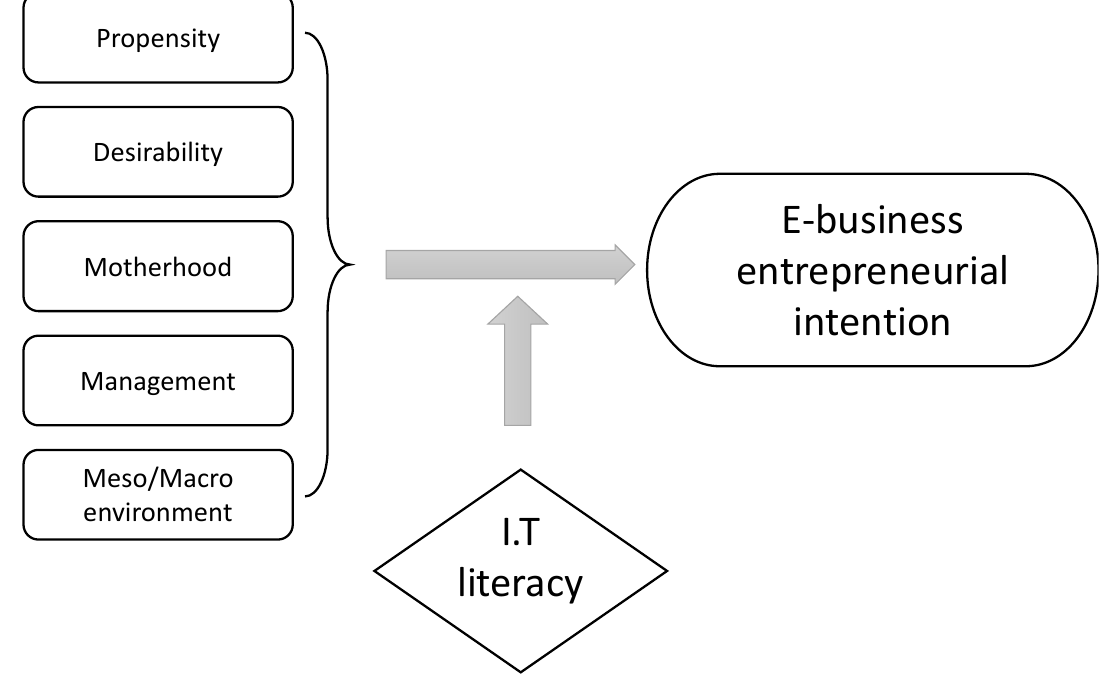
Figure 7. E-Business Entrepreneurial Intention Model for